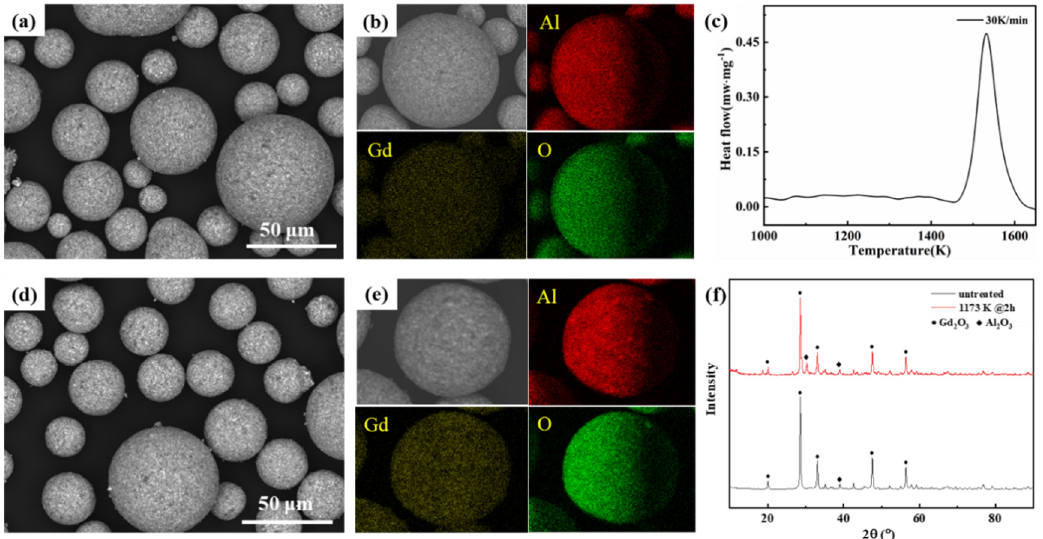
Figure 1. ( a ) SEM image of granulated powders (the lower-left corner shows the particle size distribution of granulated powders); ( b ) the morphology of the single granule and related element distribution; ( c ) DSC curve of Al 2 O 3 /Gd 2 O 3 granulated powders at the heating rate of 30 K/min; ( d ) SEM image of granulated powders sintered at 1173 K for 2 h; ( e ) the morphology of the single granule sintered at 1173 K for 2 h and related element distribution; ( f ) XRD patterns of Al 2 O 3 /Gd 2 O 3 granulated